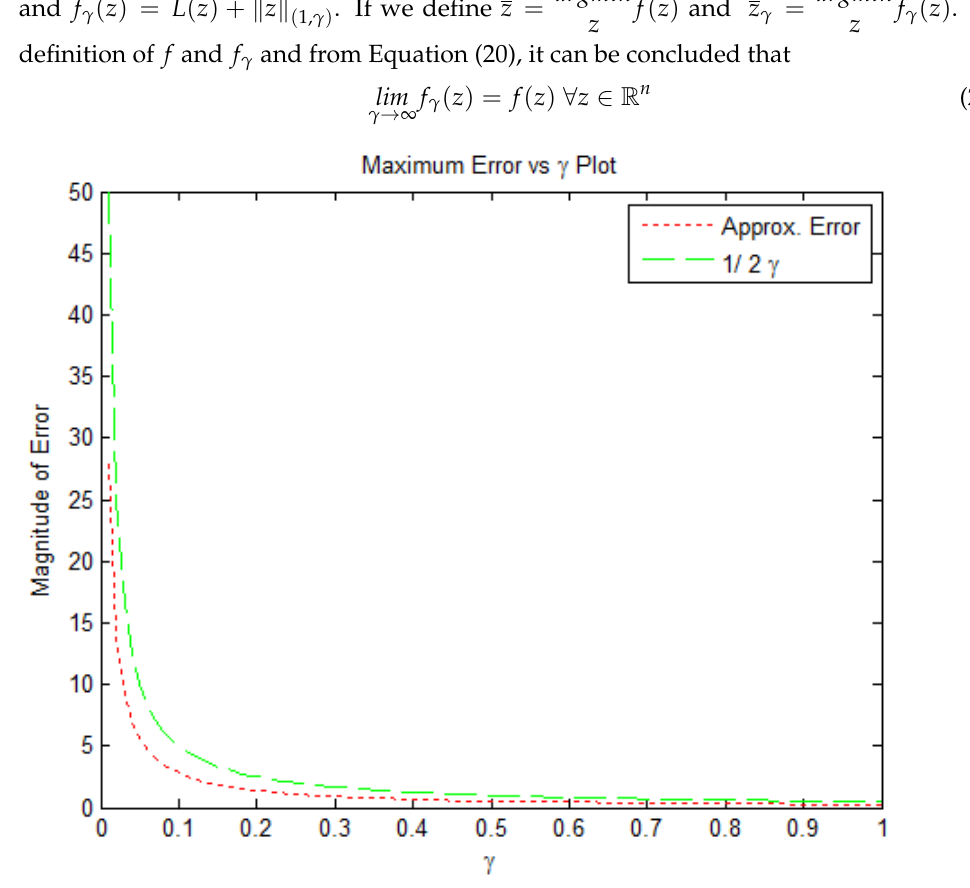
Figure 3. 𝒍 𝟏 norm approximation error bounds for 𝒛 < 𝟎 , the green line shows the upper bound proved mathematically in Equation (19), whereas the dotted red line shows the actual error between proposed 𝒍 𝟏 norm smooth approximation and actual non-differentiable 𝒍 𝟏 norm. The error is maximum at approximately zero and approaches zero as 𝜸 → ∞ .